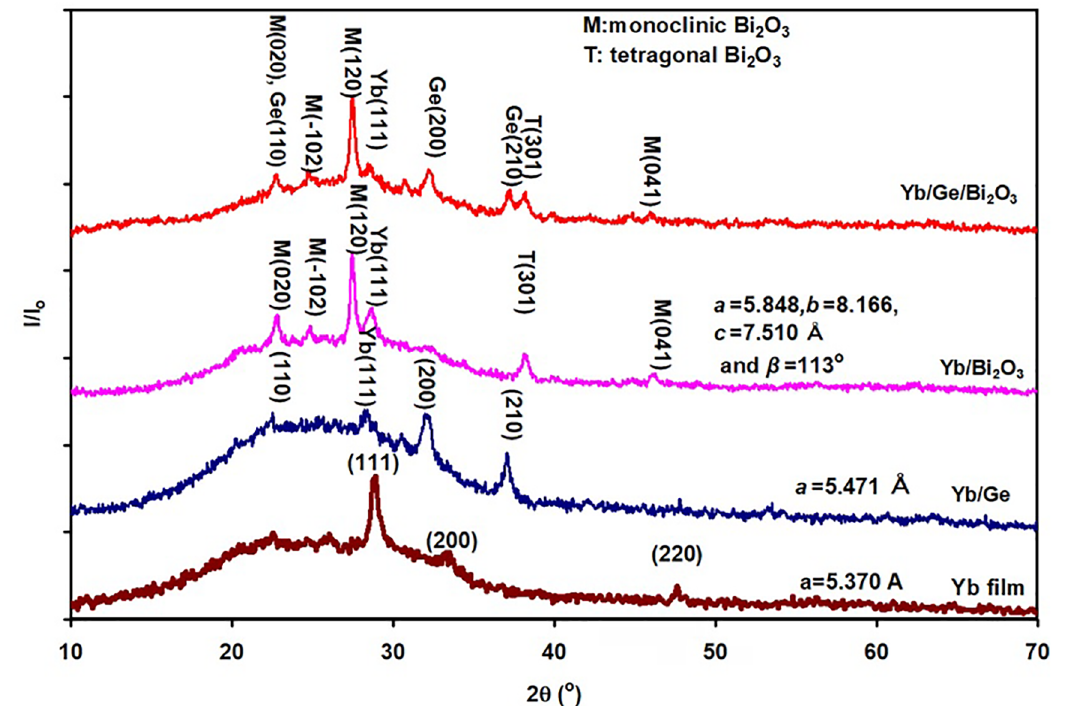
O interface deposited onto glass and Yb 2 3